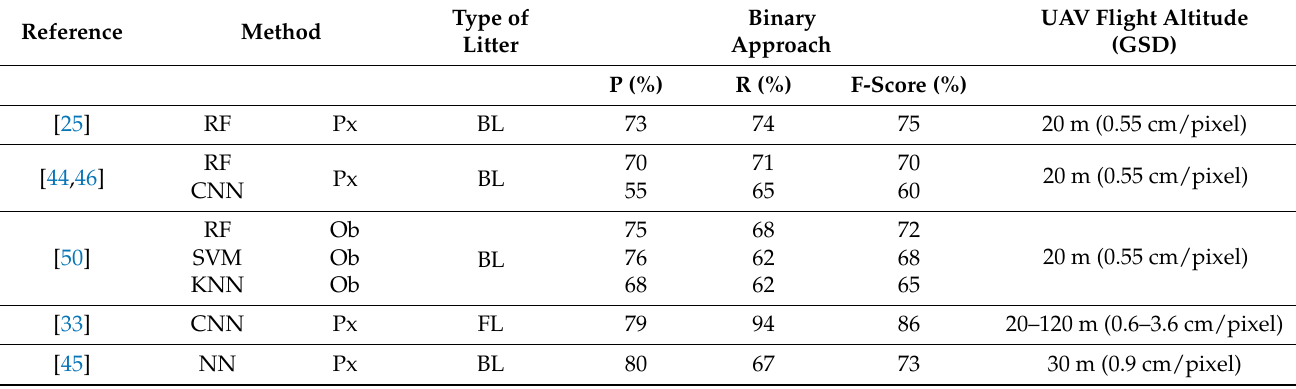
Table 2. Different approaches developed for automated image detection of beached (BL) and floating (FL) litter items. Machine learning classifiers include random forest (RF), Convolutional Neural Network (CNN), Support vector machine (SVM), k-nearest neighbors (KNN), and neural network (NN). Both pixel-based (Px) and object-based (Ob) approaches were tested. Assessments for the binary approach (litter/non-litter identification) are reported in terms of precision (P), recall (R) and